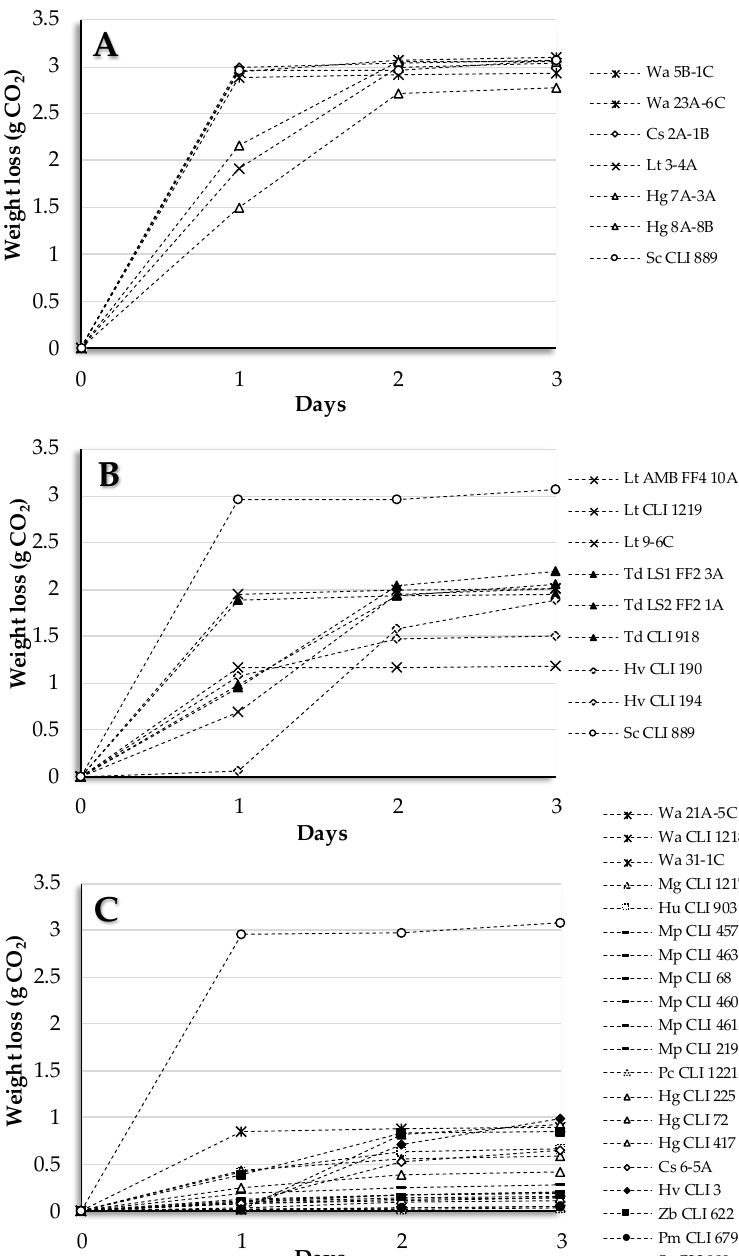
Figure 1. Release of CO 2 in aerobic conditions. (A) Six non- Saccharomyces strains showed similar CO 2 released to Sc CLI 889 control strain (white circles). (B) Eight non- Saccharomyces strains showed less CO 2 released than the control (white circles). (C) Nineteen non- Saccharomyces strains showed values below 1 g of CO 2 liberated from the control (white circles). Wa, W. anomalus ; Cs, C. stellata ; Lt, L. thermotolerans ; Hg, H. guilliermondii ; Sc, S. cerevisiae ; Td, T. delbrueckii ; Hv, H. valbyensis ; Mg, M. guilliermondii ; Hu, H. uvarum ; Mp, M. pulcherrima ; Pc, P. carsonii ; Hv, H. vineae ; Zb, Z. bailii ; Pm, P. membranifaciens